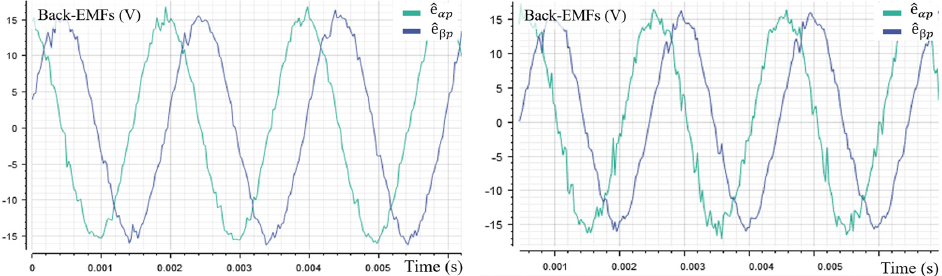
Figure 20. Back-EMFs estimates at maximum speed: Healthy ( left ) under OPF ( right ).